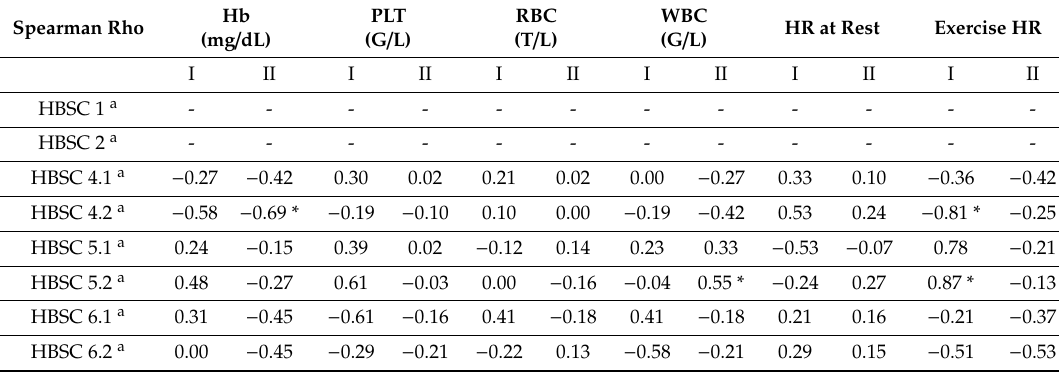
Table 11. Correlation between the survey results that assessed the level of physical activity and sedentary behaviors and blood count parameters and heart rate with the division into age groups (7–10 and 11–13 years of age). Values of p < 0.05 were considered statistically significant. a The question content of the HBSC questionnaire is presented in Table 7.